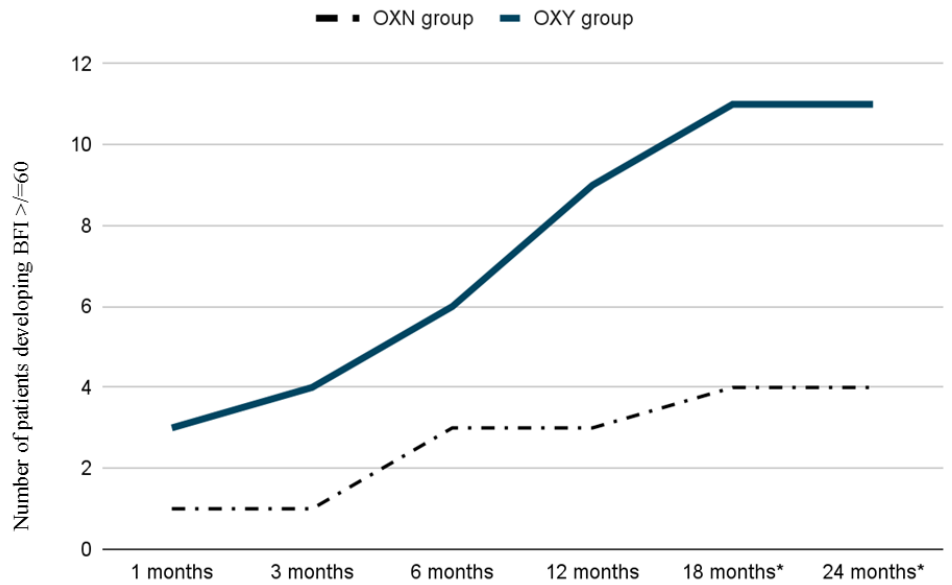
Figure 2. Distribution of patients (absolute number) developing BFI ≥ 60 during follow-up time. OXY group: oxycodone; OXN group: oxycodone-naloxone. * Statistically significant differencereached ( p < 0.05). Table 3. Reported opioid side effects or adverse events as recorded per single group (OXY vs. OXN). Values are expressed as the number of patients. Group OXY, oxycodone; Group OXN, oxycodone +